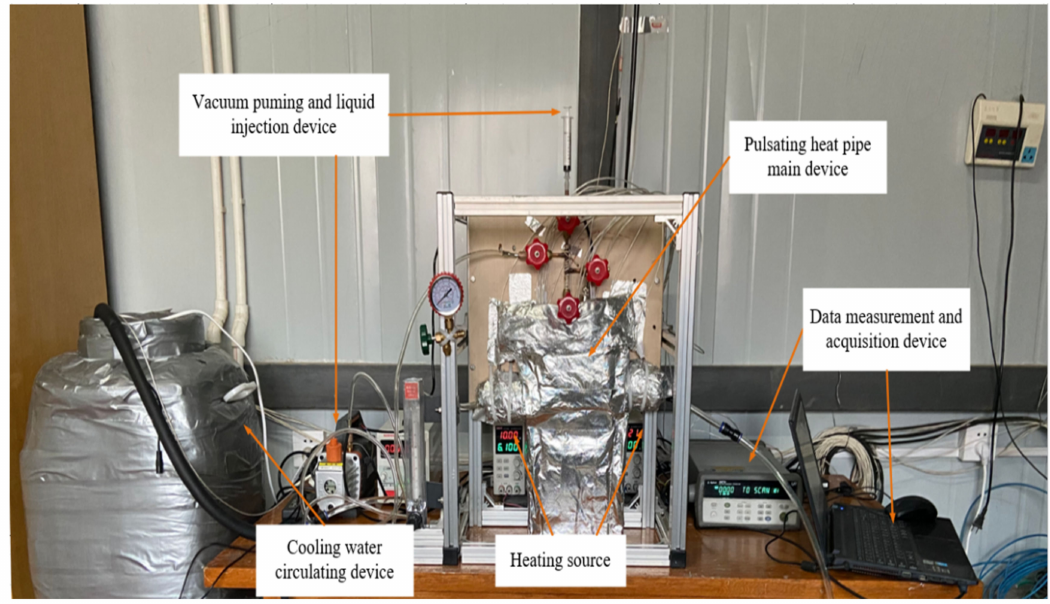
Figure 1. Physical diagram of pulsating heat pipe experimental device with non-uniform